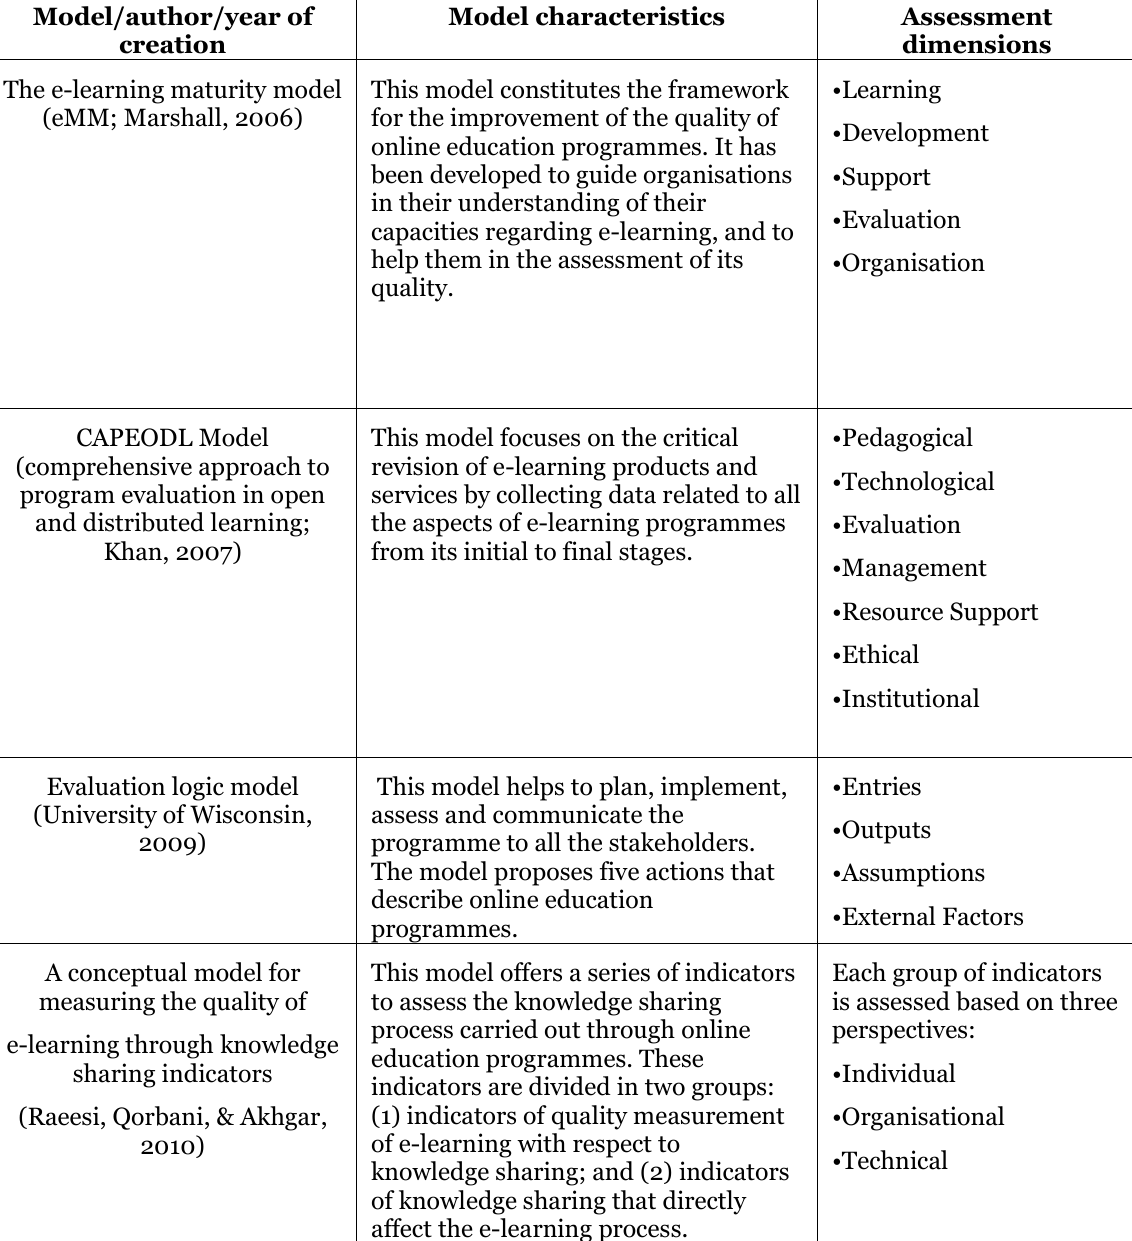
Table 1 Comparative Analysis of Some of the Models Developed to Assess the Quality of Online Education Model/author/year